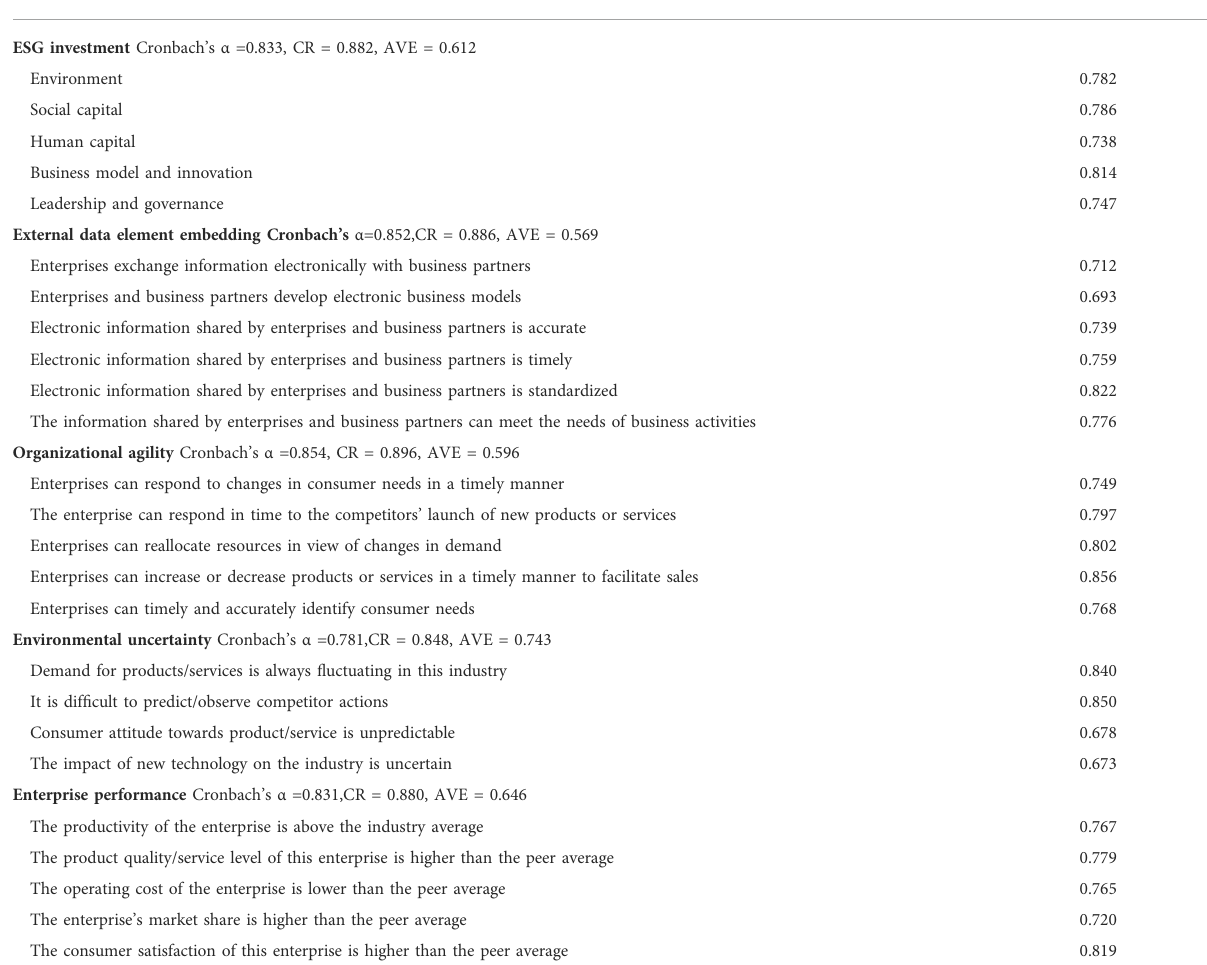
TABLE 1 Reliability and validity analysis of the measurement